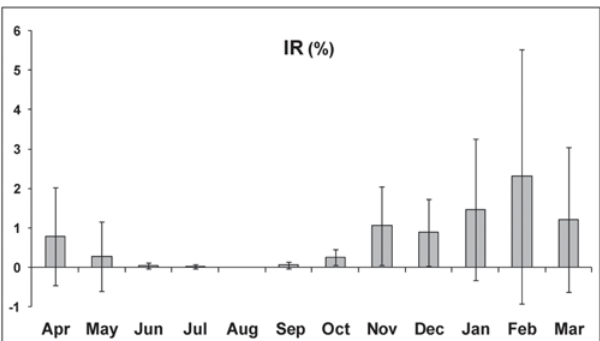
Fig. 4. Numeric Frequency (FN) of the food items of Cichla kelberi during the collection